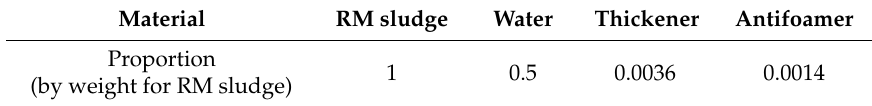
Figure 2. Homo mixer.